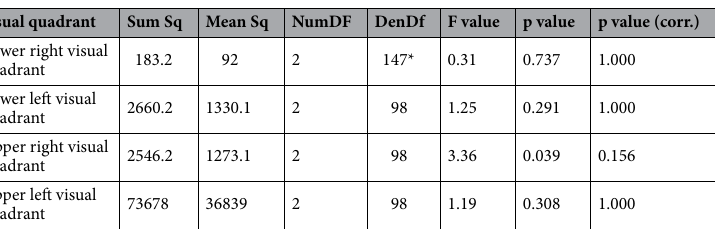
Table 3. Effect of alignment method on position selectivity within group ROIs. To test whether the strength of position selectivity within corresponding group ROIs across alignment techniques increases for the more advanced alignment techniques, we conducted separate linear mixed models with random intercept for each visual quadrant. For each position, we used each subject’s t-values as the dependent variable and the alignment techniques (VBA, SBAV and CBA) as the independent variable. We adjusted p-values using Bonferroni correction. We did not observe any significant effect (all p adjusted > 0.05), indicating that this measure of position selectivity within corresponding group ROIs was not affected by alignment technique. Thus, while for each alignment method and visual quadrant the corresponding ROI did show significant position selectivity, the strength of within-ROI position selectivity did not increase for more advanced alignment techniques. *Random effect variance estimate at the subject-level for the LR ROI was 0, resulting in a singular fit when using lmer. Therefore, results for LR were estimated without random intercept are thus equivalent to a regular ANOVA. Sum Sq sum of squares, Mean Sq mean square, NumDf degrees of freedom in the numerator, DenDf degrees of freedom in the